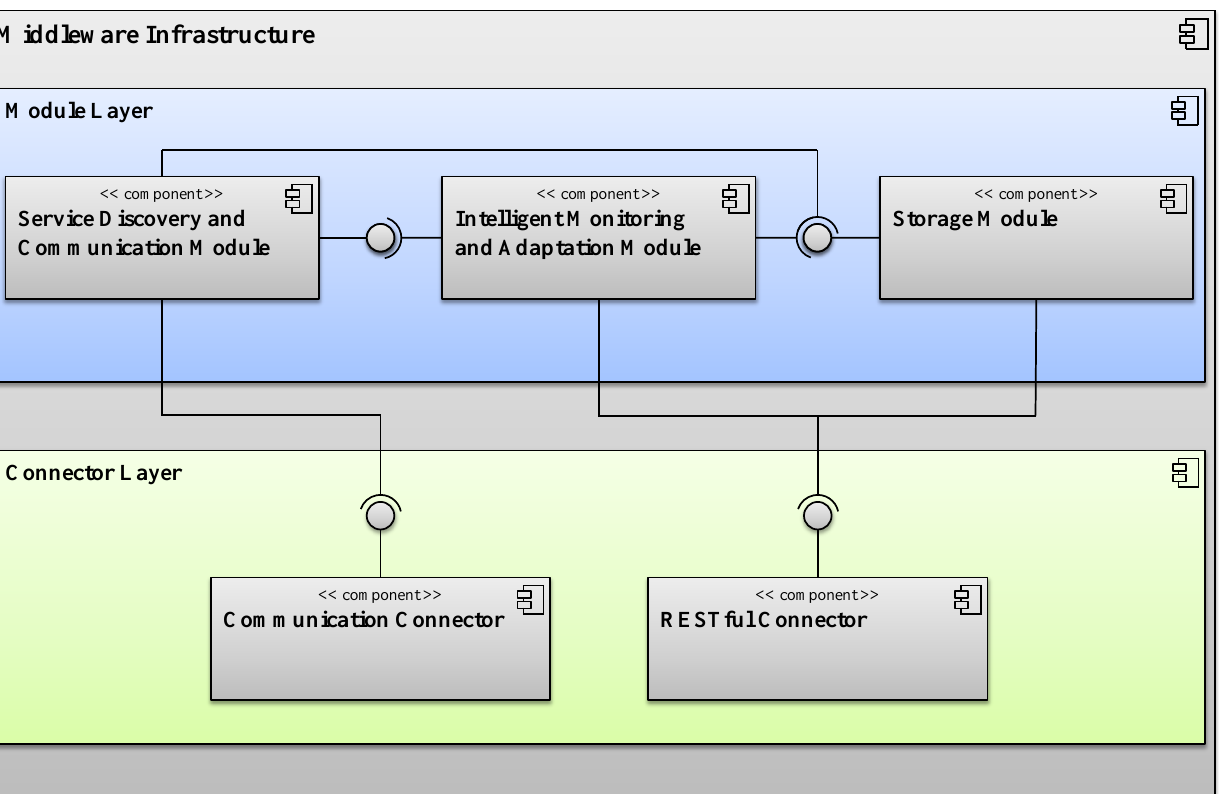
Figure 3. An in-depth view of the middleware